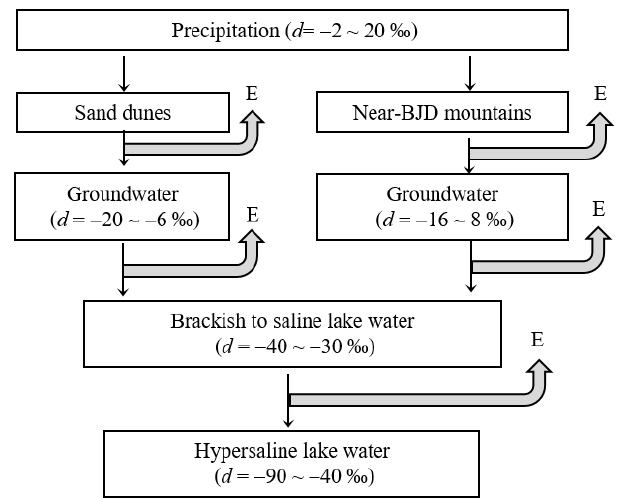
Figure 6. The conceptual model of the d -excess changing routines in the BJD. E represents